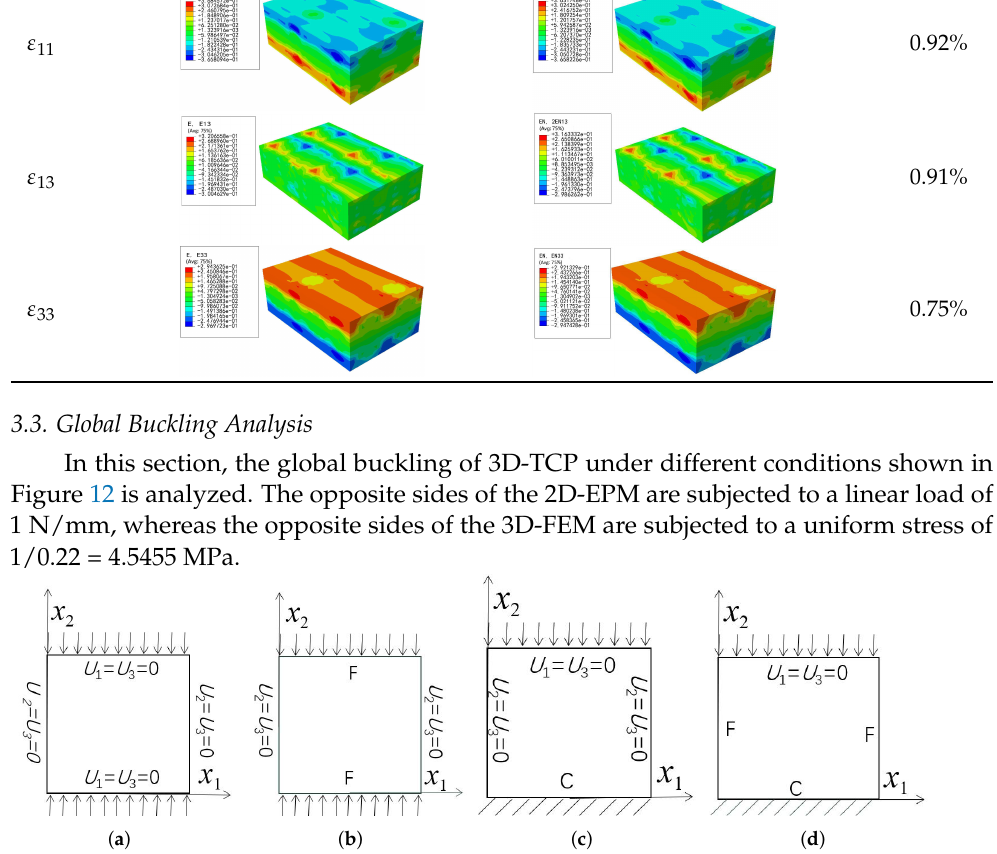
Figure 12. Boundary and load conditions used in bucking analysis. ( a ) Case 4; ( b ) Case 5; ( c ) Case 6; and ( d ) Case 7.